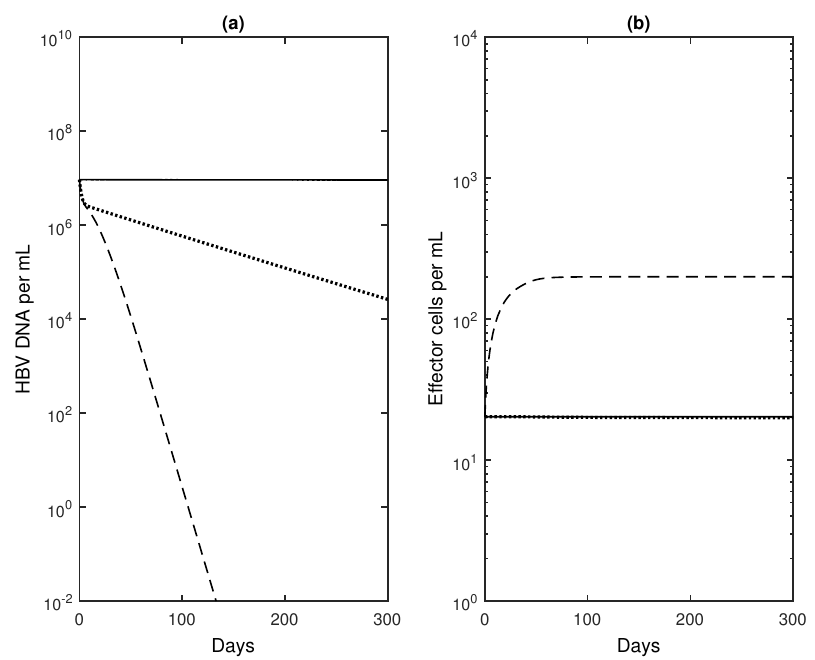
Figure 3. ( a ) Virus V per mL and ( b ) Effector cells E per mL given by model (1) and parameters in Table 1 for η = (cid:101) = 0 (solid lines); η = 0.5, (cid:101) = 0.9, a 1 = a 2 = a 3 = b 1 = b 2 = 1, f = 0.5 (dashed lines); and η = 0.5, (cid:101) = 0.9, a 1 = a 2 = b 1 = b 2 = 1, a 3 = 0, f = 0.5 (dotted lines). Here, t = 0 corresponds to both the start of therapy and the steady state of the viral load, i.e., the initial conditions are T ( 0 ) = 3 × 10 5 cells per mL, I ( 0 ) = 3.8 × 10 4 cells per mL, V ( 0 ) = 9.33 × 10 6 HBV DNA per mL, E ( 0 ) = 20.3 cells per mL and R ( 0 ) = 1.33 × 10 7 cells per